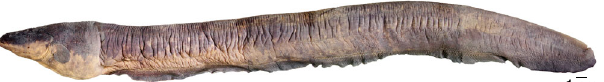
Fig. 7 Lateral view of Electrophorus voltai sp. nov. Holotype, Museu Paraense